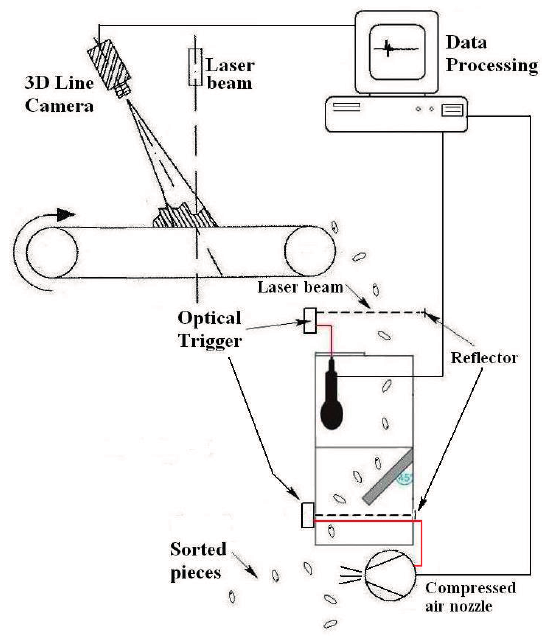
Figure 2. Experimental impact AE sorting